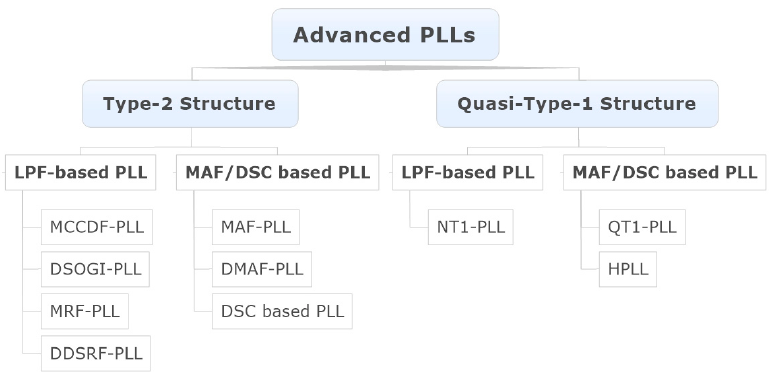
Figure 2. A general classification of typical advanced PLLs.